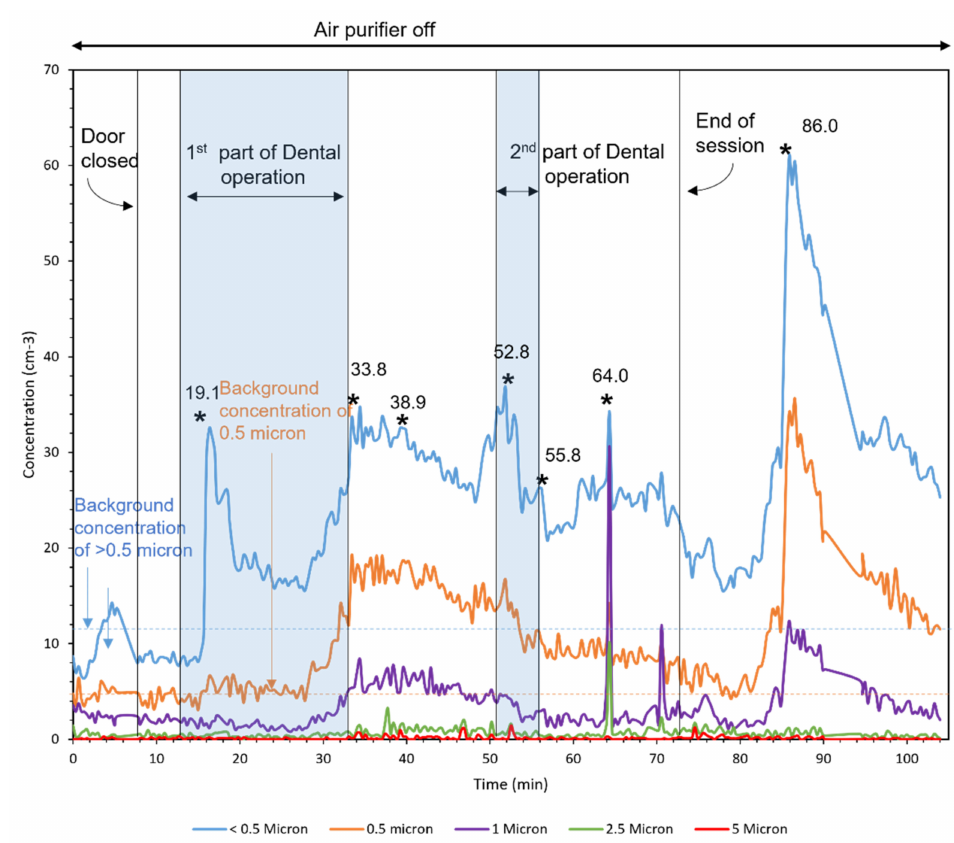
Figure 10. Operation 3 in room B (small room). Asterisks in the figure represent the moments that the door was